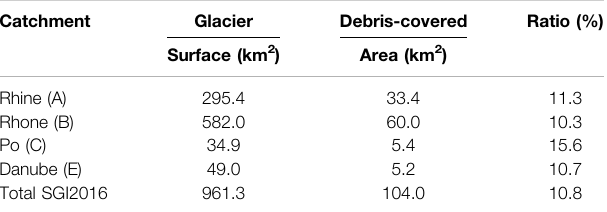
TABLE 4 | Area and ratio of debris-covered glacier surface per main hydrological catchment and for the entire inventory. Catchment